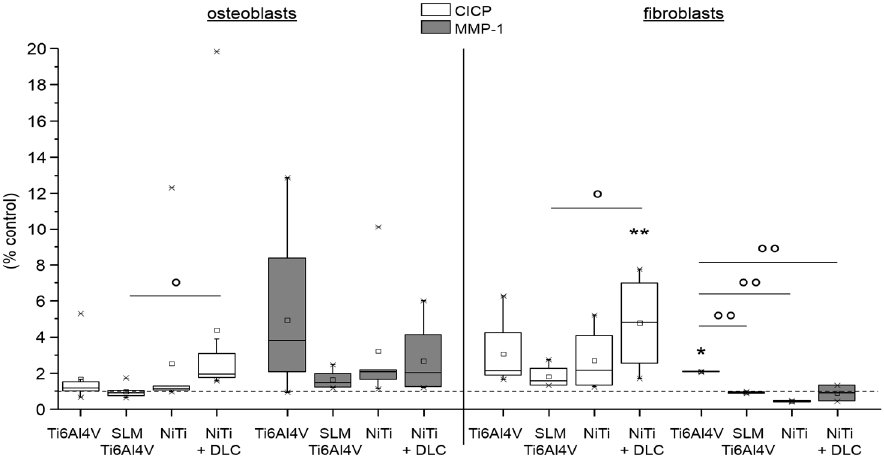
Figure 9. Pro-collagen type I synthesis (white) and MMP-1 synthesis (gray) of human osteoblasts ( n = 8, left) and human fibroblasts ( n ≥ 2, right) after 96 h of cultivation on several test pellets (forged Ti6Al4V, Ti6Al4V SLM, NiTi, NiTi + DLC). Boxes denote interquartile ranges, horizontal lines within the boxes denote medians, and whiskers denote minimum and maximum values. For statistical analysis, ANOVA was conducted. Data were compared with the respective growth control (100%, * p ) and with each other (° p ). * p < 0.05, ** p < 0.01; ° p < 0.05, °° p < 0.01.